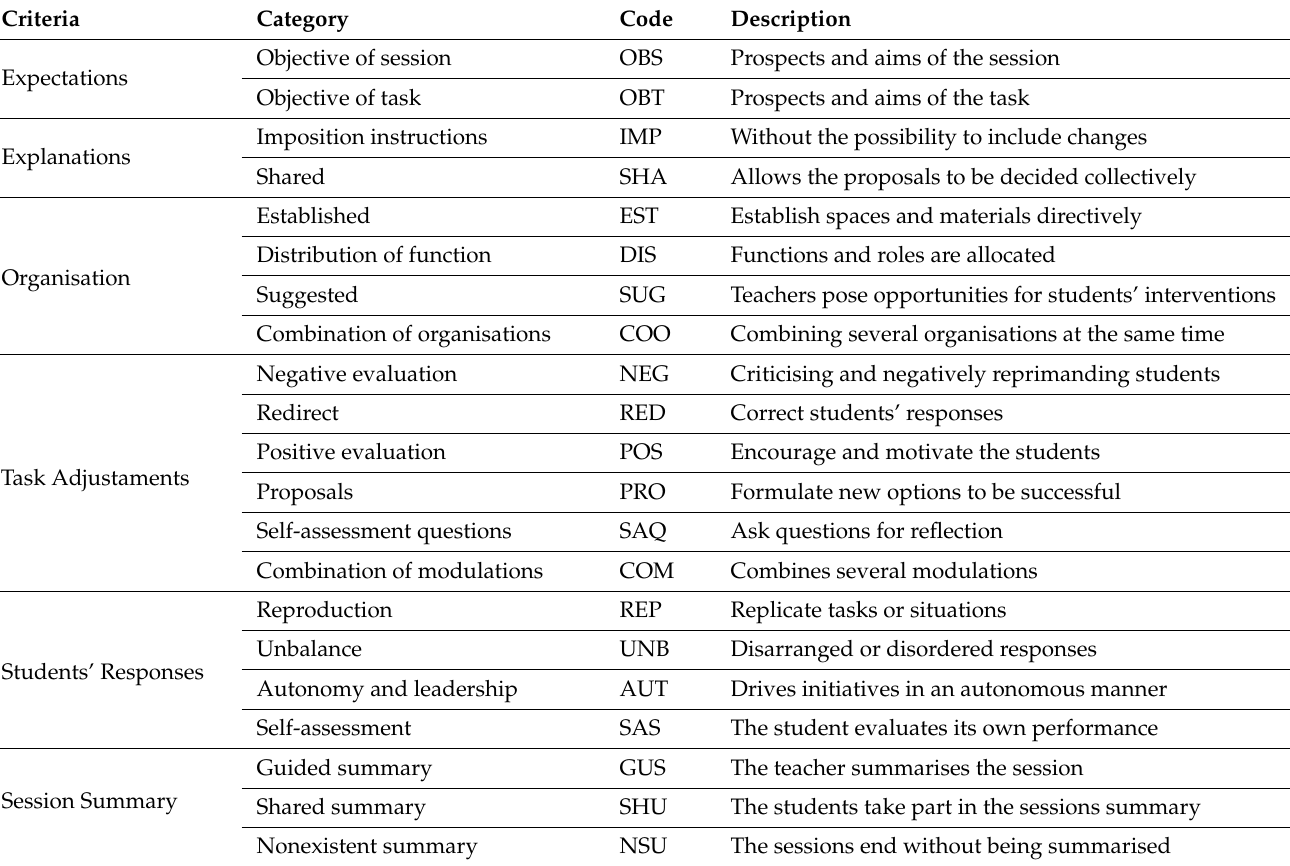
Table 1. Observation system for teaching-oriented responsibility